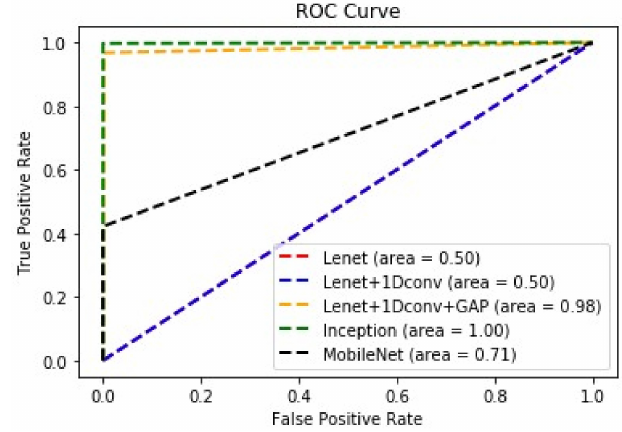
Figure 13. Receiver Operating Characteristic (ROC)